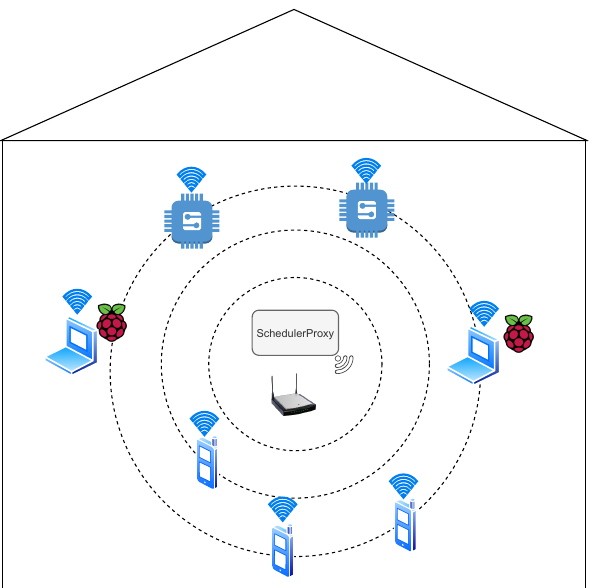
Figure 1. Example of a smart cluster at the Edge architecture. In this example, there are eight devices connected to the local network and communicating to a central scheduler. The devices include three smartphones, two raspberry pis, two PCs, and the device assigned as the